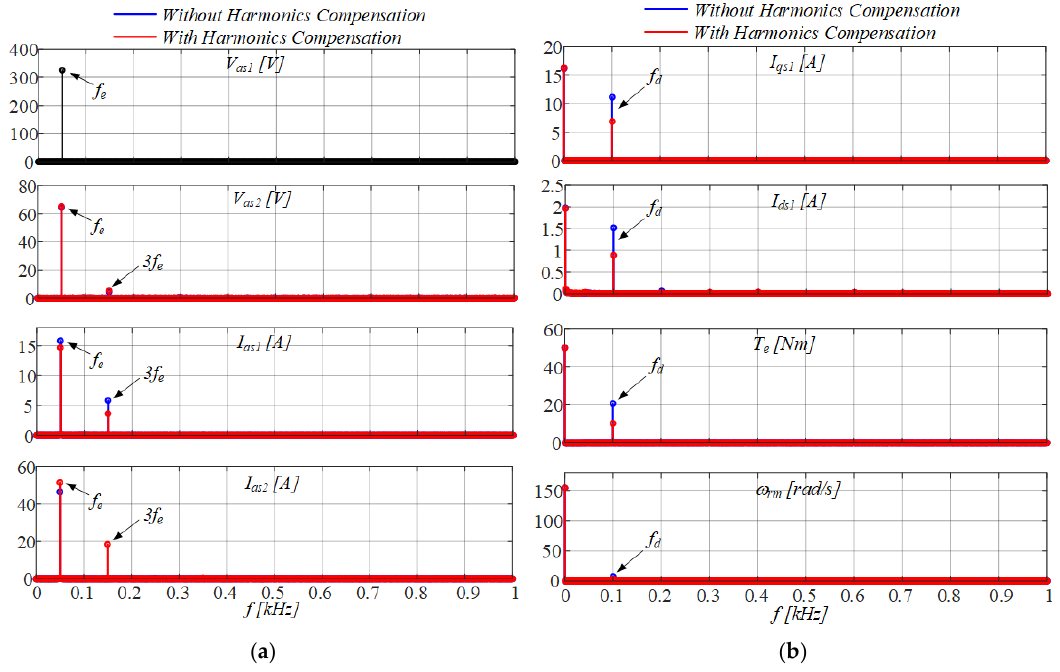
Figure 14. Harmonic content of motor quantities with and without the harmonic compensation when a sinusoidal torque disturbance is applied to the shaft: ( a ) main winding phase stator amplitude voltage Vas1 , auxiliary winding phase stator voltage amplitude Vas2 , main winding phase stator amplitude current Ias1 , auxiliary winding phase stator amplitude current Ias2 ; ( b ) qd-axes main winding stator current Iqs1 and Ids1 , electromagnetic torque Te , mechanical speed ω rm .